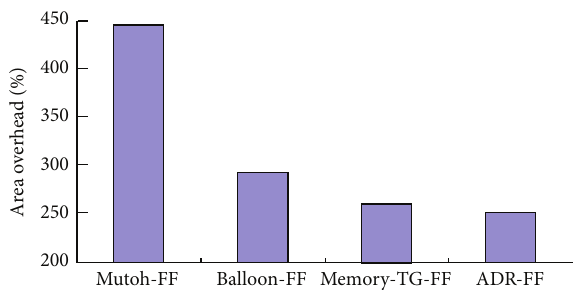
Figure 11: The area overhead of different flip-flops as compared to ST-TG-FF.